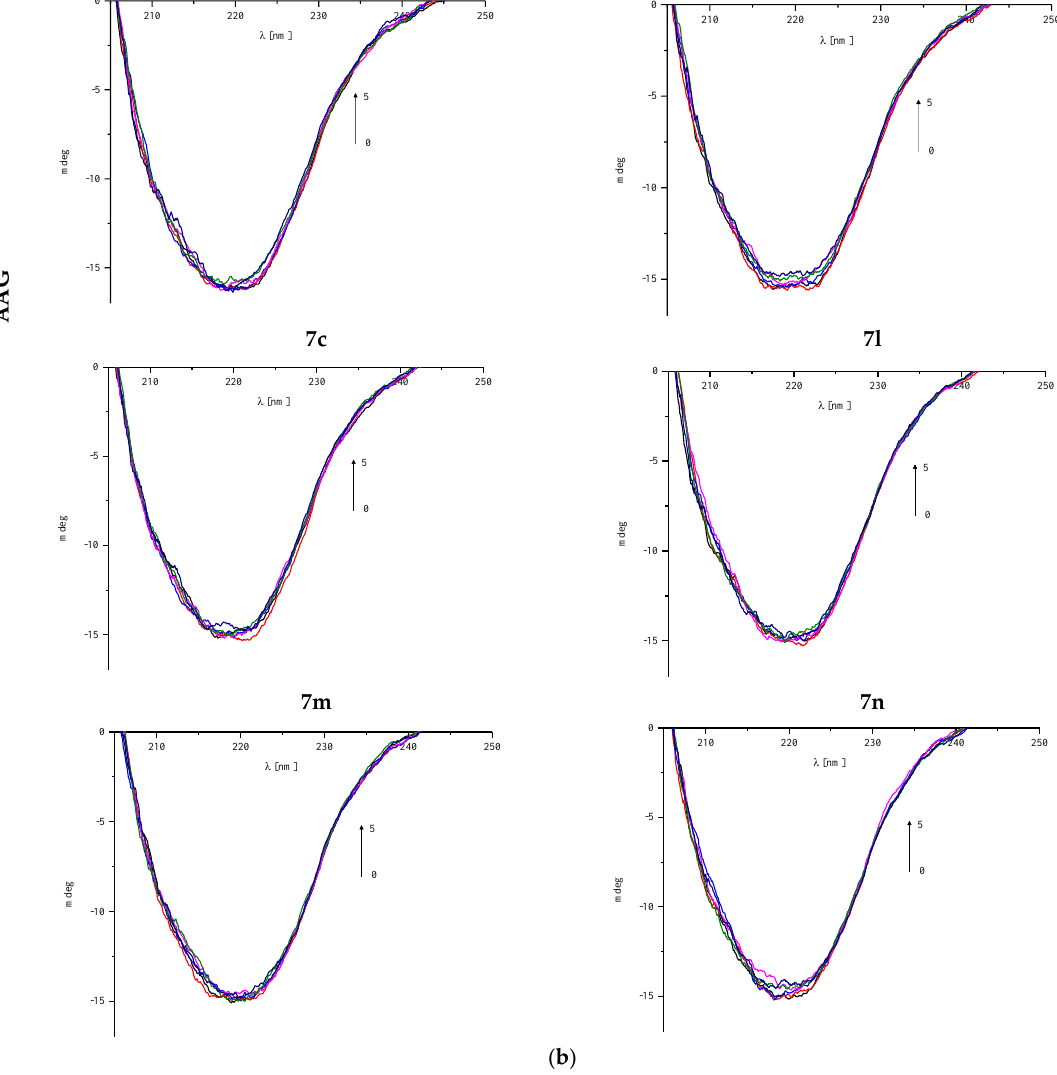
Figure 10. ( a ) Circular dichroism spectra of human serum albumin (HSA) in the absence and presence of analyzed compounds 7a – 7c and 7l – 7n . ( b ) Circular dichroism spectra of alpha-1-acid glycoprotein (AAG) in the absence and presence of analyzed compounds 7a – 7c and 7l – 7n . Table 12. Percentage of content of dominating secondary structure elements α - helix and β -sheet in alpha-1-acid glycoprotein (AAG) in the absence and presence of compounds 7a – 7c and 7l – 7n , calculated in the CD Multivariate SSE program.